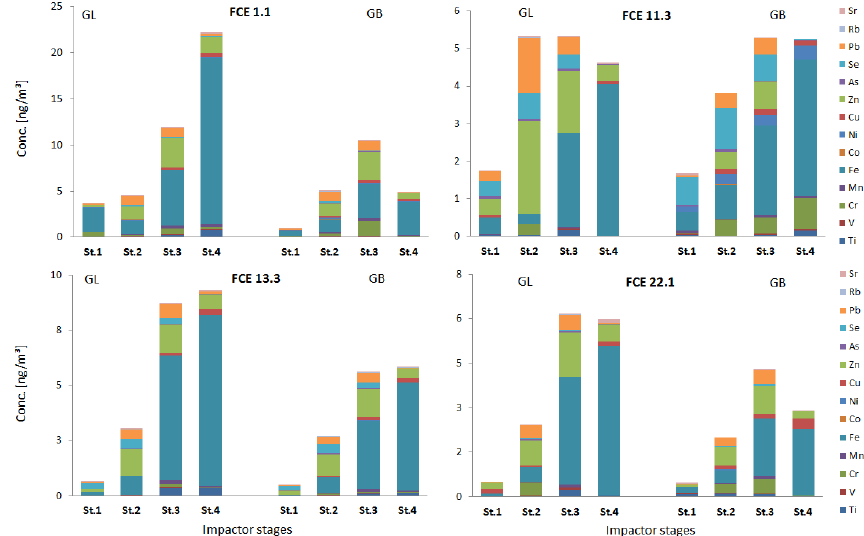
Figure 1. Aerosol particle size-resolved trace metal concentrations during four full cloud events at Goldlauter (GL) and Gehlberg (GB). The PM stage cutoffs for St. 1 to St. 4 are 0.05, 0.14, 0.42, 1.2, and 3.5µm,